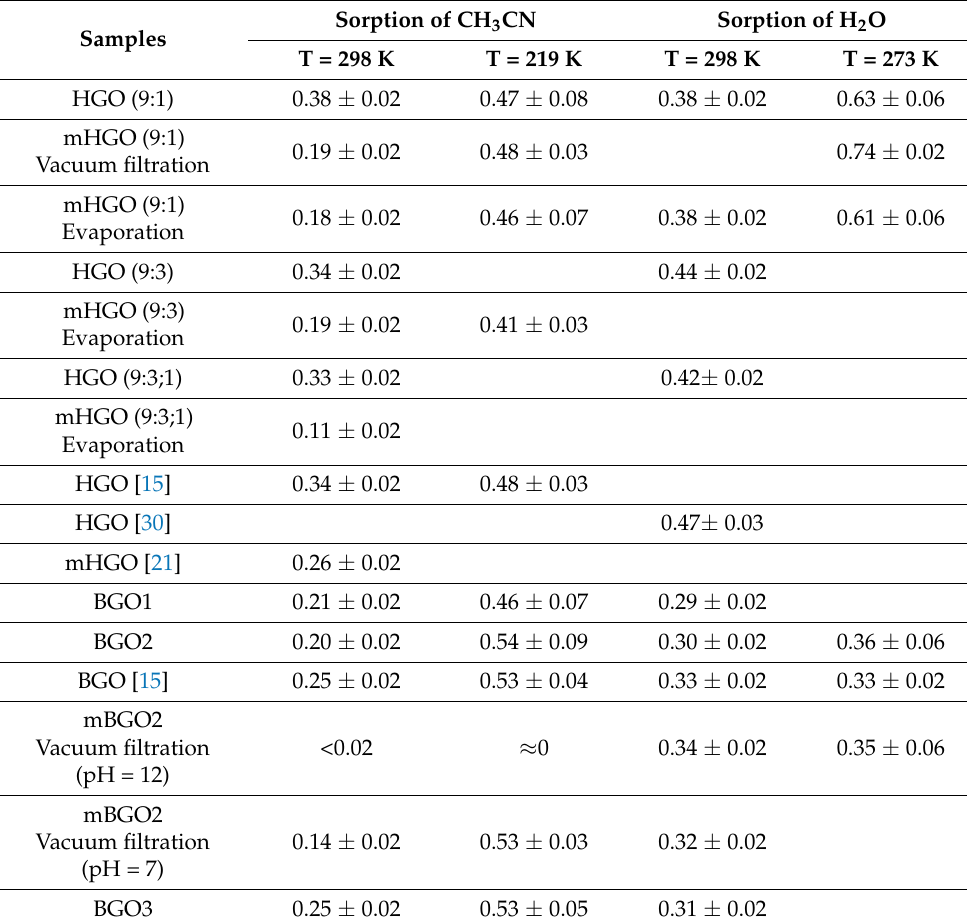
Table 3. Sorption of acetonitrile and